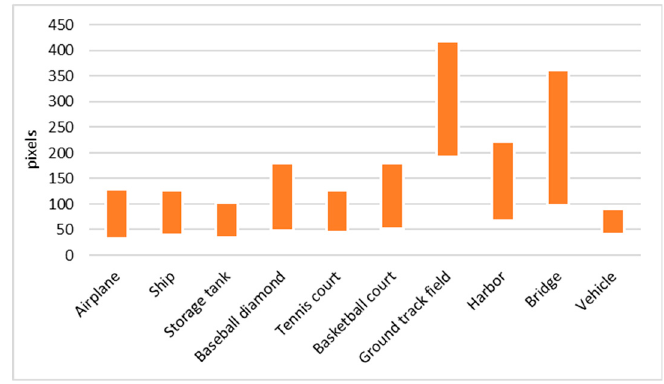
Figure 8. Object sizes of each class in the NWPU VHR-10 dataset.